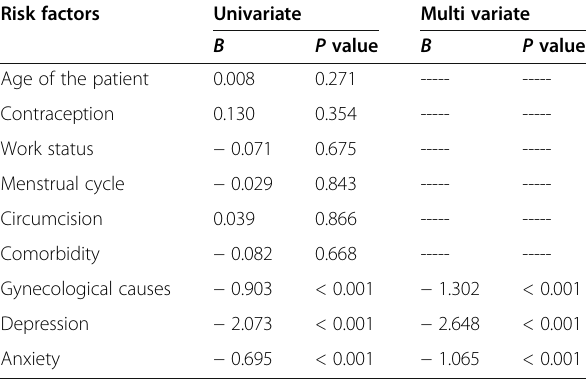
Table 5 Univariate linear regression of pain score with different risk